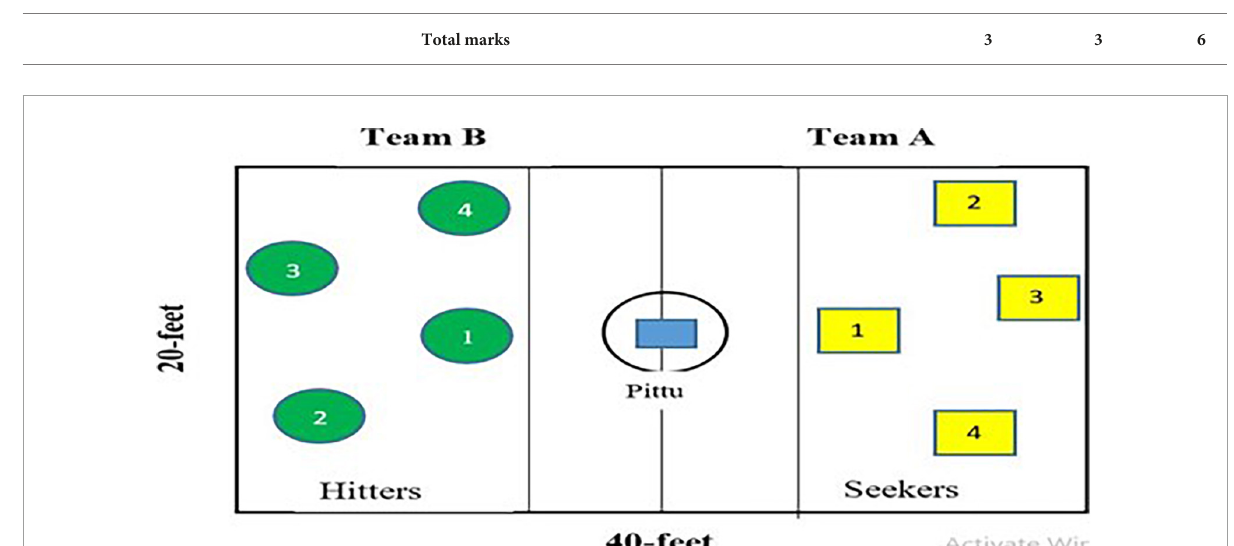
FIGURE2 Layout of game transfer test for the game of Pittu Garam .